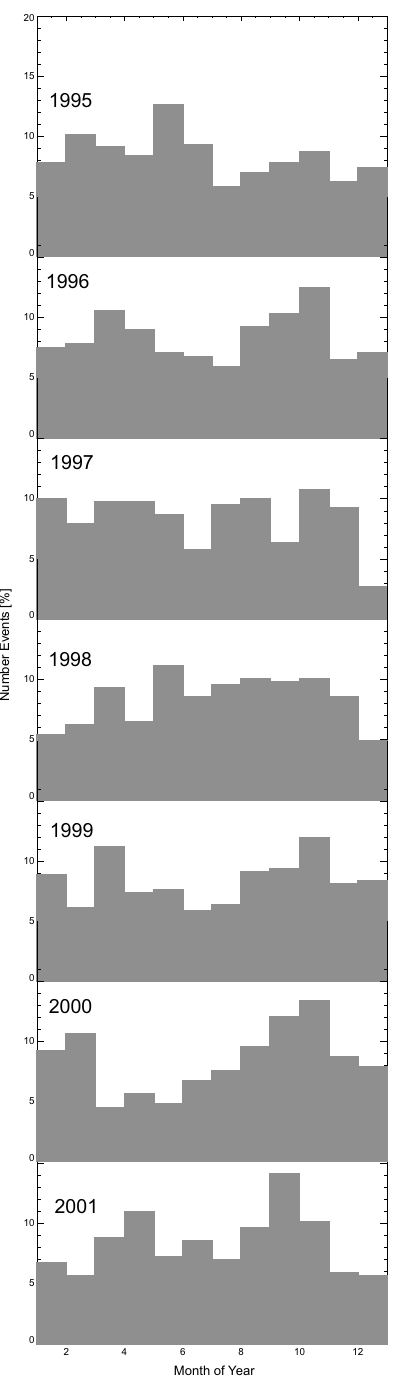
Fig. 3. Relative monthly occurrences for each year are displayed in the panel. The format of the gray block-diagrams is the same as for Fig. 2